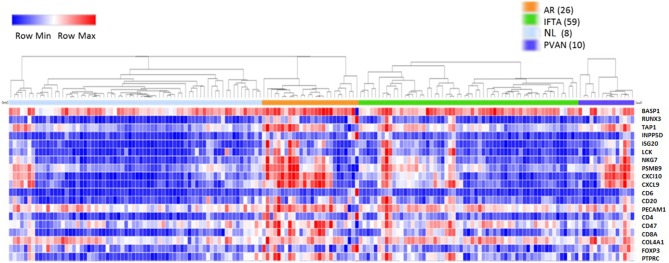
Heterogeneity of kidney graft injury across different injury phenotypes. As anticipated, CRM genes and genes specific to immune related genes are upregulated in the tissue from recipients of kidney transplantation with AR episodes. In addition, increased gene expression is seen with PVAN and IFTA subtypes. Furthermore, some tissues from normal graft biopsies also had molecular signatures that correspond to inflammation.